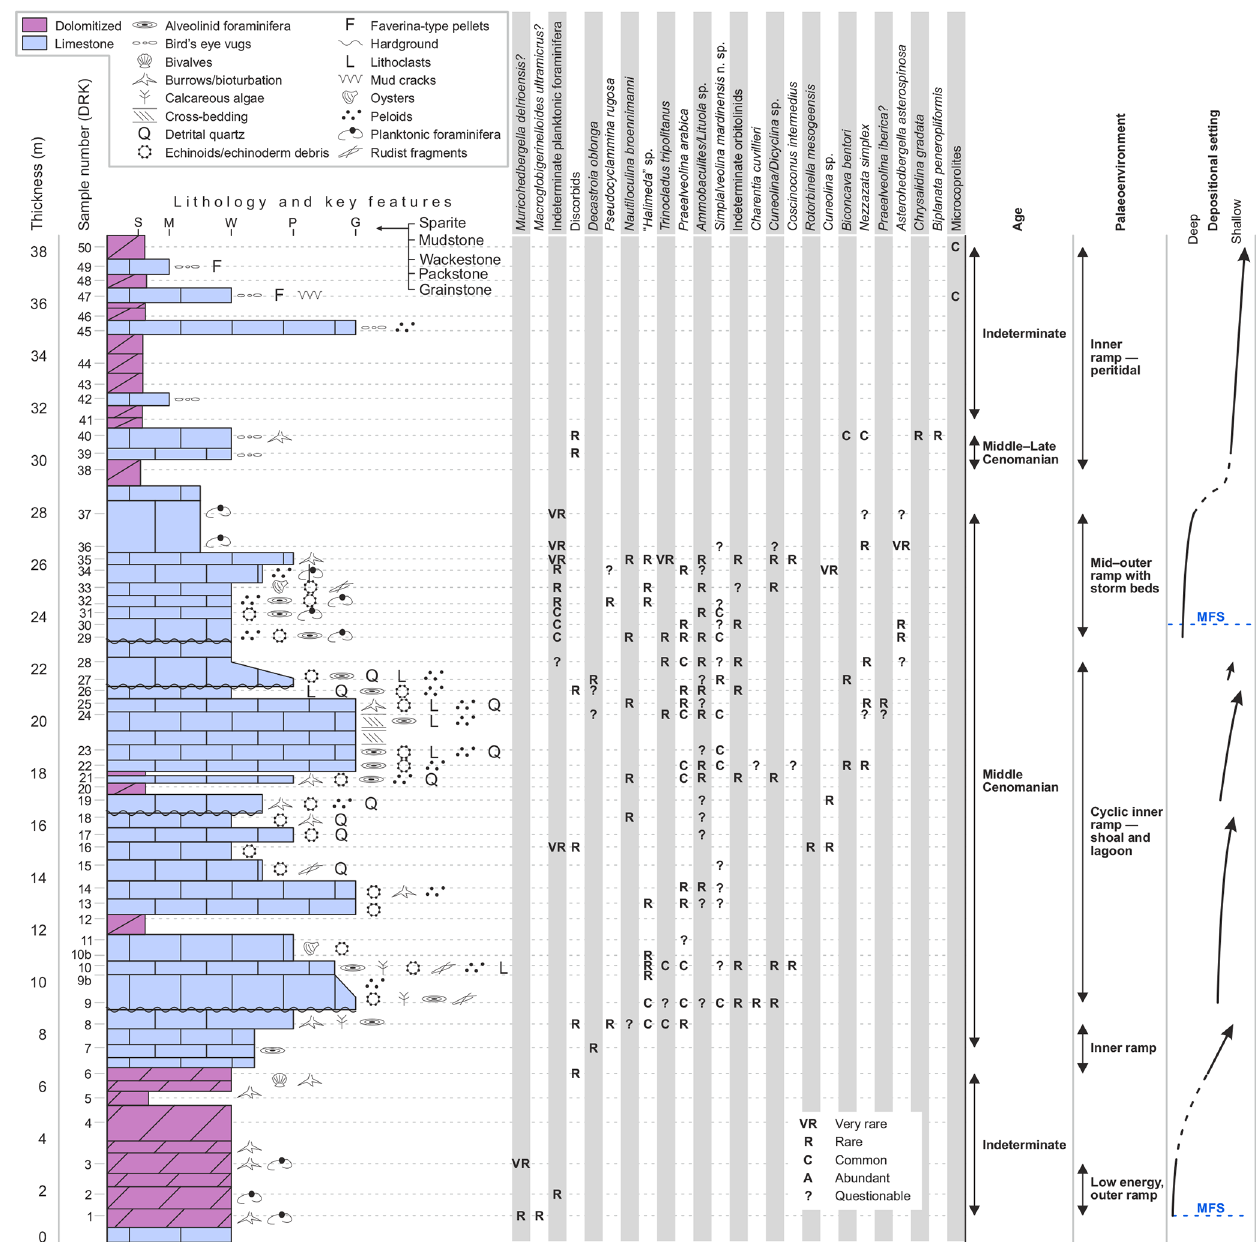
Figure 3. Lower Derdere Formation at Derik with sedimentological and petrographic information, micropalaeontology, age and palaeoenvi- ronmental interpretation, and identification of deposition trends. MFS stands for possible maximum flooding